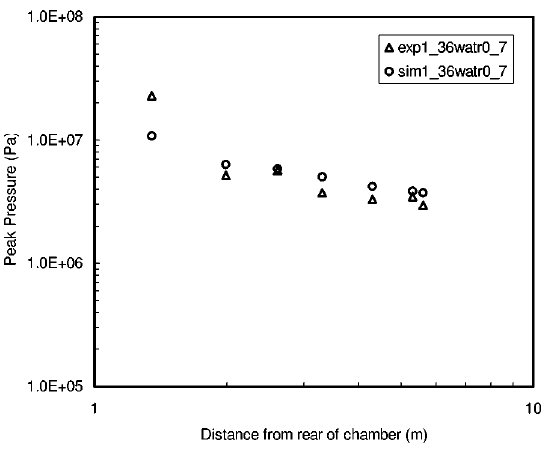
Fig. 10. Comparison between experiment and computation for 1.36 kg C4 charge detonation with water ( R = 2 :